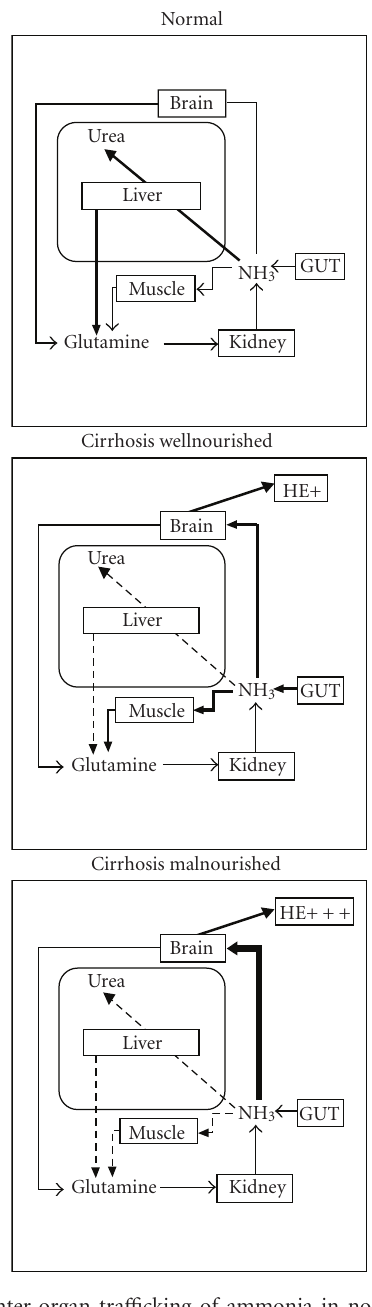
Figure 2: Inter-organ tra ffi cking of ammonia in normal physio- logical conditions, in well-nourished patients with end-stage liver failure compared to malnourished end-stage liver failure